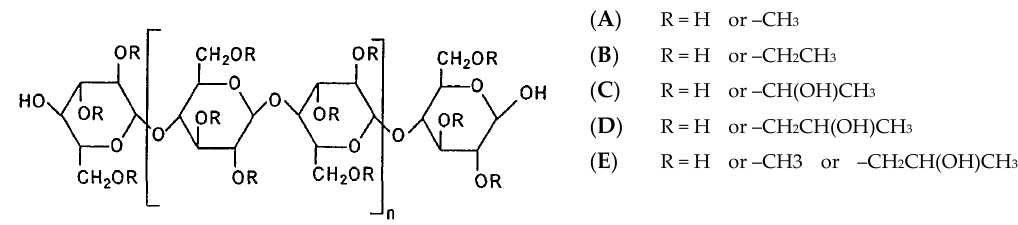
Figure 6. Chemical structure of cellulose ethers derivatives—methylcellulose ( A ), ethylcellulose ( B ), hydroxyethylcellulose ( C ), hydroxypropylcellulose ( D ), and hydroxypropylmethylcellulose ( E ).